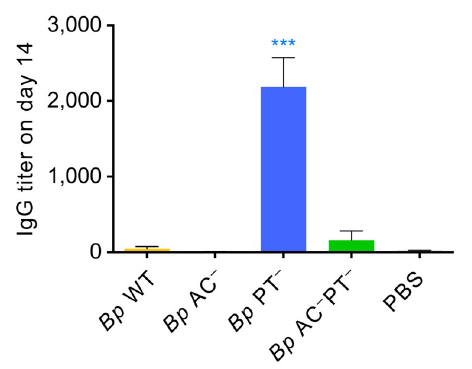
Fig 9. PT action prevents early adaptive immune response to B . pertussis infection. Sera of mice were collected 14 days after infection with 8 x 10 5 CFU of the indicated B . pertussis strains (mScarlet + ). Total anti- B . pertussis IgG antibody titters were determined by whole bacterial cell ELISA using plates coated with heat-killed B . pertussis (Tohama I). Mean antibody titers were determined as the inflection points of titration curves +/- SD. Pools of sera from 2 mice from two independent experiments (total n = 4 mice/group) were analyzed in technical triplicates. Groups were compared to Bp WT using one-way ANOVA with Dunnett’s multiple comparisons test. � p < 0.05, �� p < 0.01, ��� p < 0.001, ���� p <